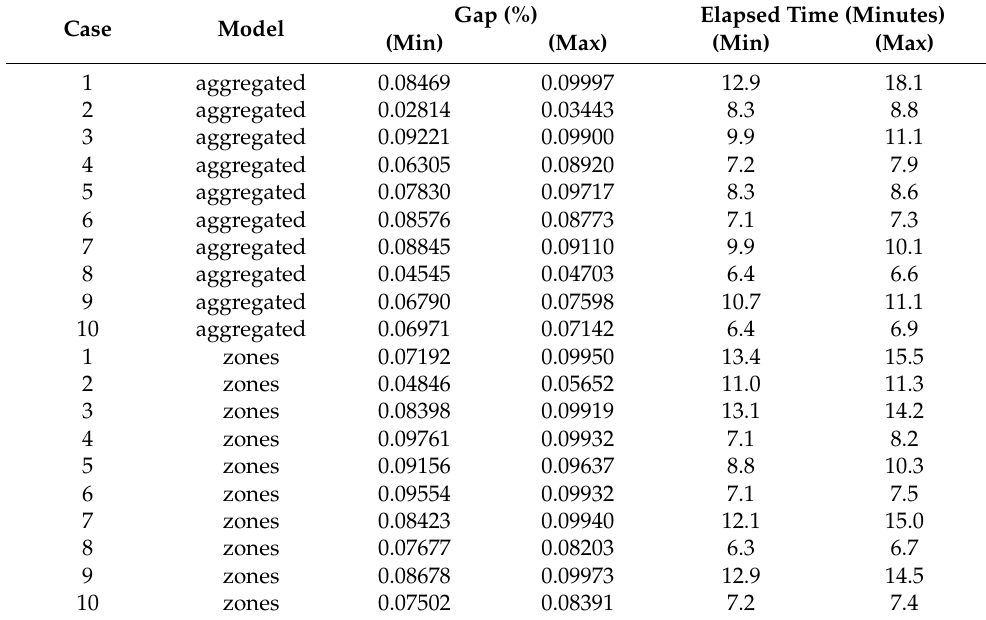
Table 4. Ranges of the gaps and computing times over the 5 trials of each